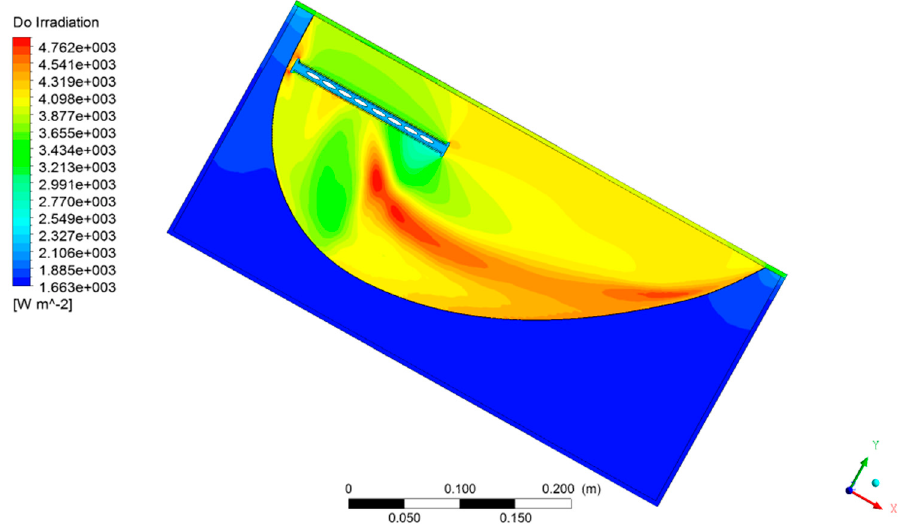
Figure 17. Discrete Ordinates (DO) radiation contour inside the collector.